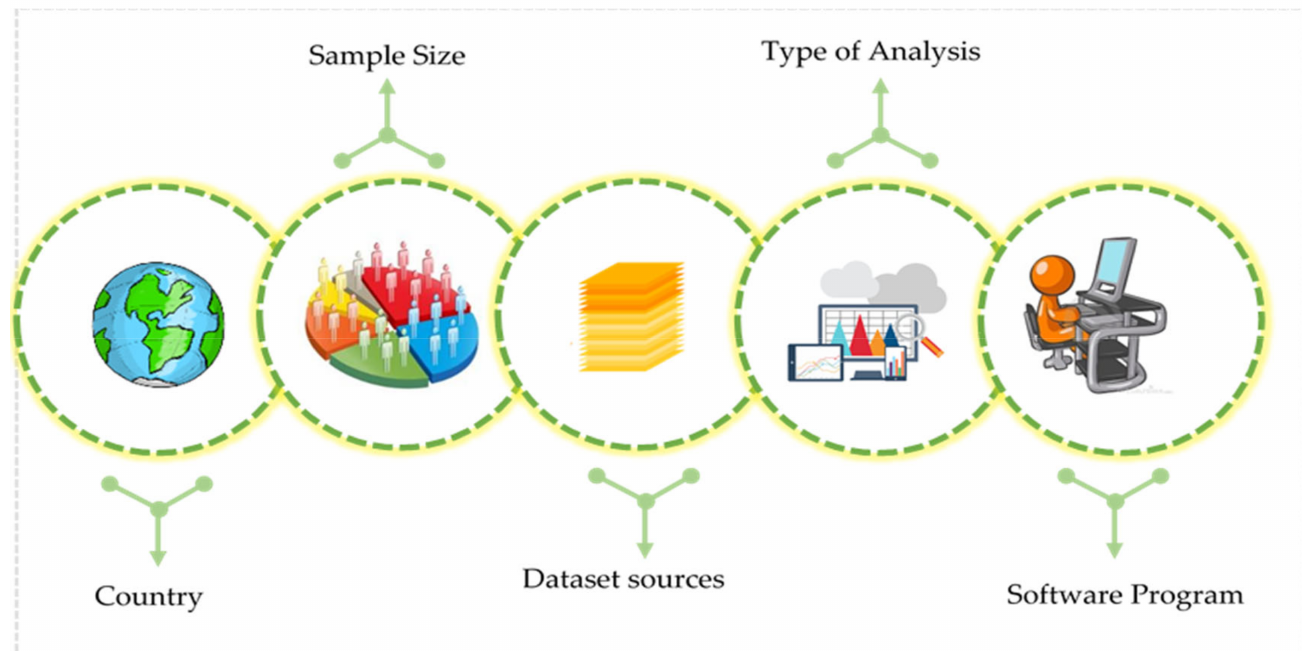
Figure 7. Methodological aspect overview.